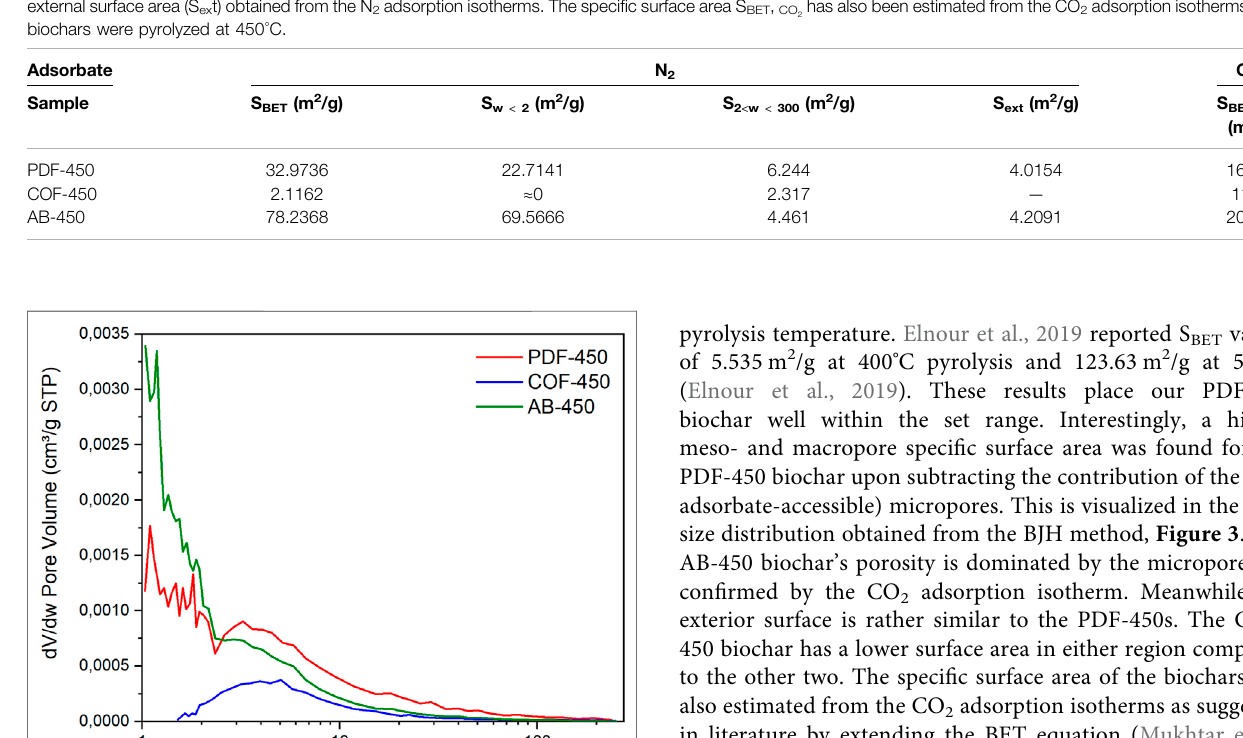
has also been estimated from the CO 2 adsorption isotherms. All 2